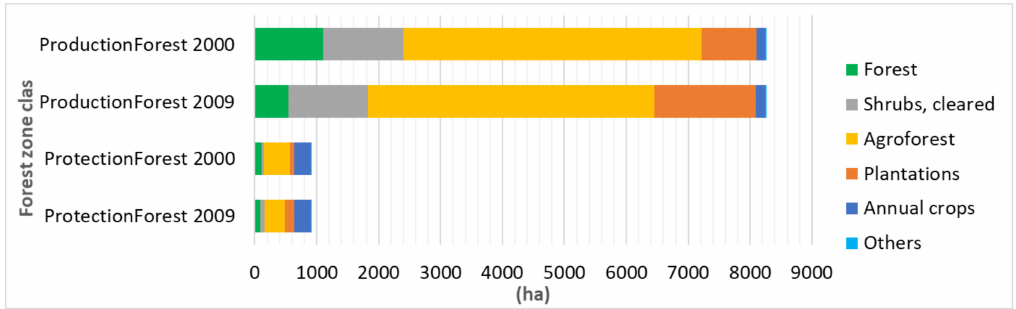
Figure 4. Land cover trajectories (2000 and 2009) of 2019 independent smallholder oil palm in each Forest-zone class in West Kalimantan (based on